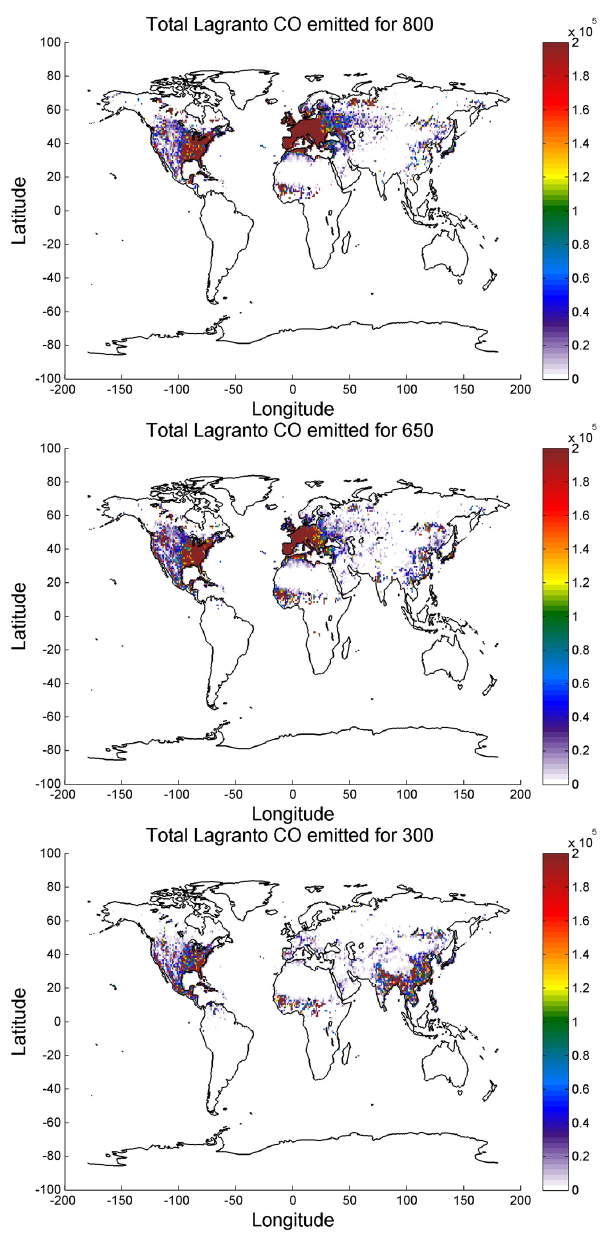
Fig. 10. Total CO emitted and transported towards Jungfraujoch at 800 (top), 650 (middle) and 300hPa (bottom) for the year 2000, using total 1997–2007 residence times, as simulated by Lagranto and EDGAR v4.1 and GFED v3 emissions. Scale ranges between 0 and 2 × 10 5